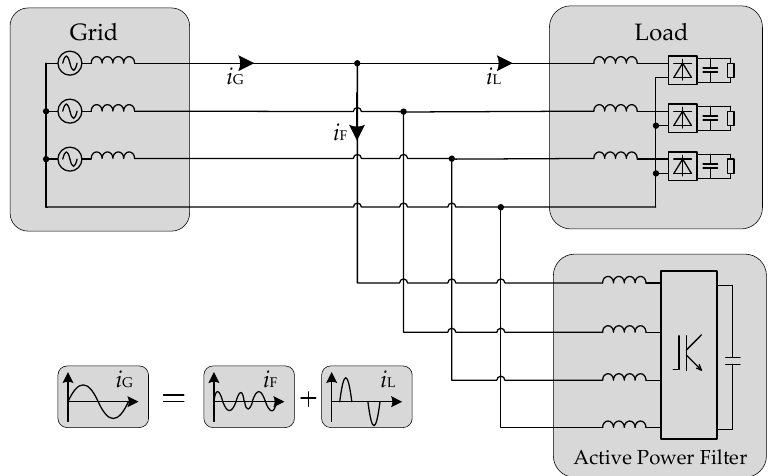
Figure 1. Connection of the active power filter to the grid.